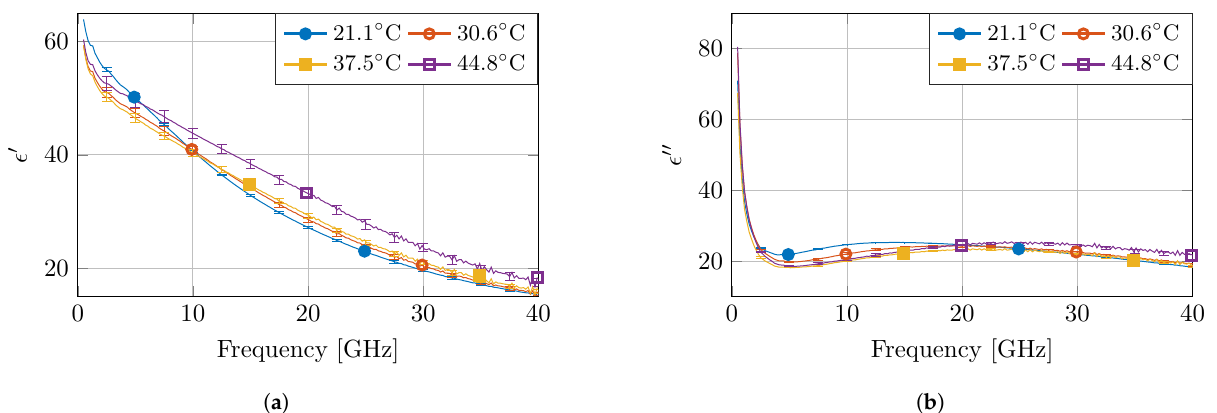
Figure 5. The measured dielectric properties at four temperatures with the corresponding standard complex uncertainty 1 s comb. for each measurement. The real and imaginary part are displayed in ( a , b ), ±